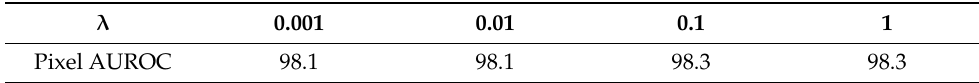
Table 4. The influence of hyperparameter λ in the carpet dataset.